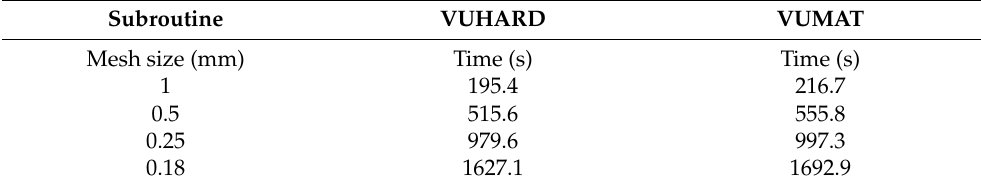
Figure 6. Curves of the numerical equivalent von Mises stress against plastic strain at a temperature of 25 ◦ C and imposed velocity of 8 m/s for different mesh sizes in numerical simulation of the SHPB test using the VUMAT and VUHARD subroutines developed in the present work. Table 4. Computation time for different mesh